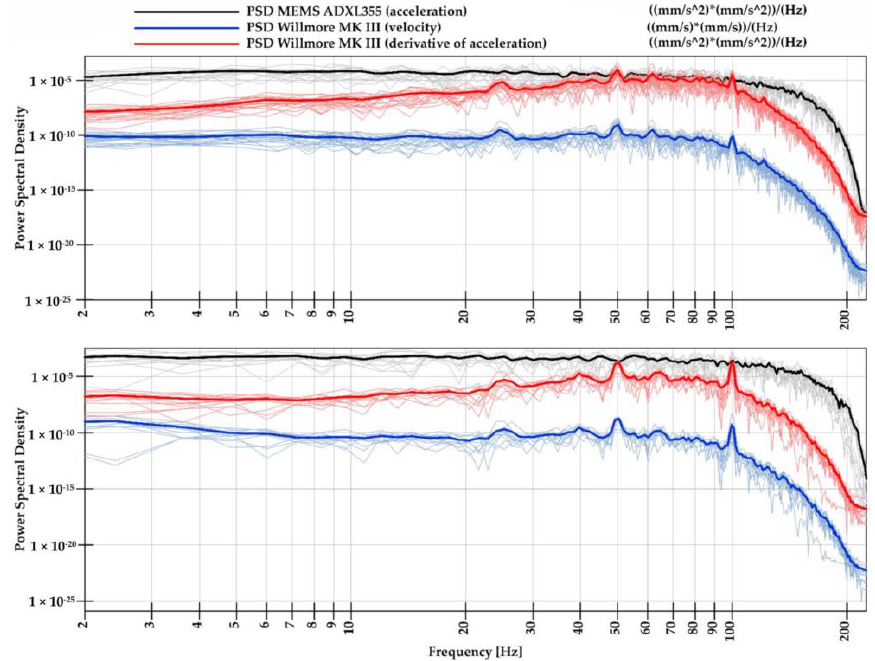
Figure 22. The PSD of noise was recorded by a mine seismometer and MEMS accelerometer in the horizontal ( top ) and vertical ( bottom ) directions [104].